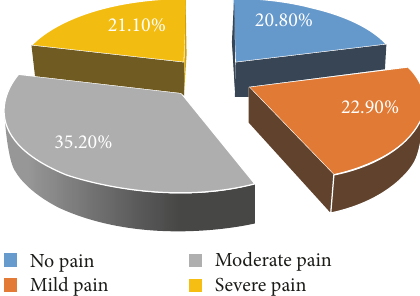
Figure 2: Degree of pain among female students of UOG, Gondar,